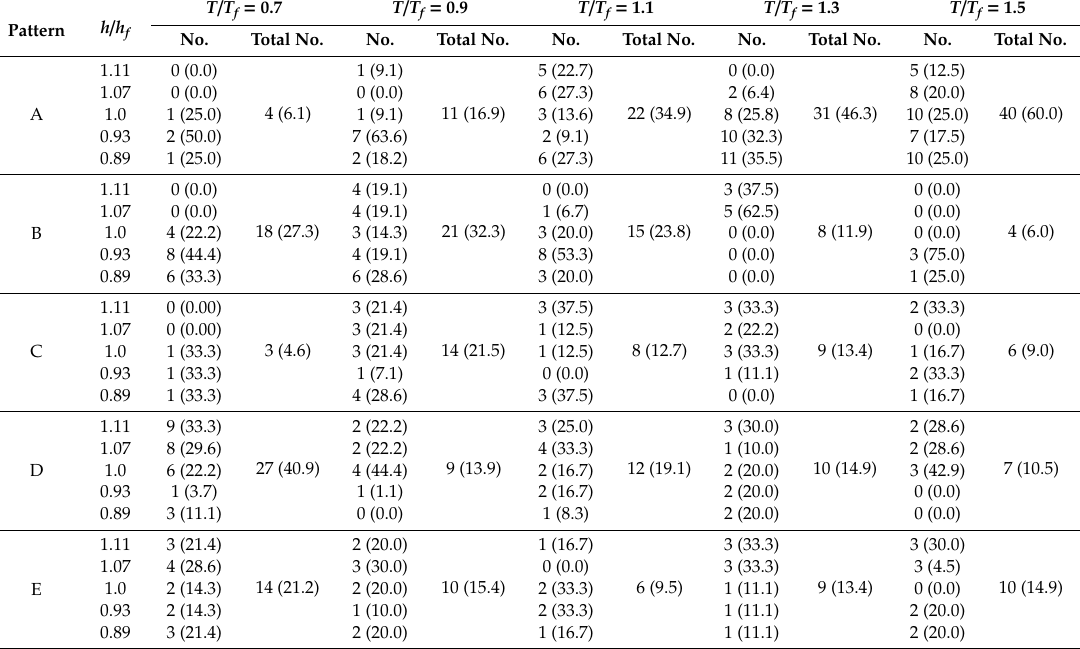
Table 4. The number of the emergence of each pattern for h / h f and T / T f . The values in parentheses “()” of No. columns represent the percentages of the number of emerged cases for each h / h f over the total number of experiments for T / T f in each pattern. The value in parentheses “()” of Total No. columns denotes a percentage of the number of occurrences of each pattern from the total number of experiments for each T / T f